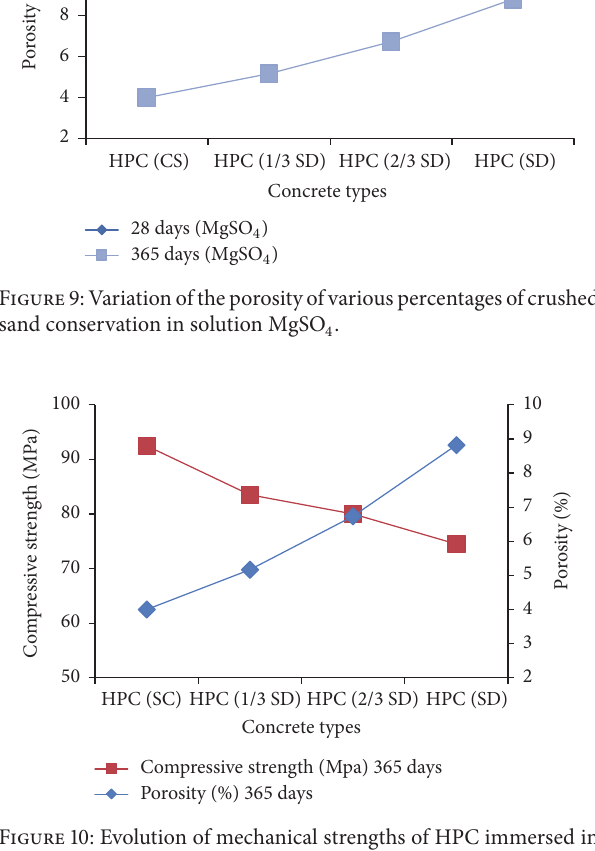
Figure 10: Evolution of mechanical strengths of HPC immersed in the solution (MgSO 4 ) depending on the